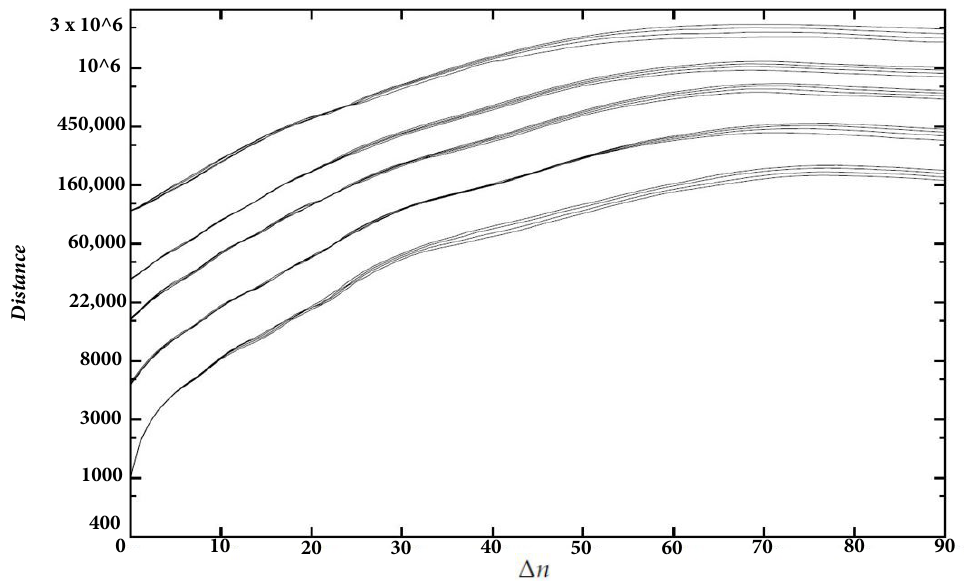
Figure 10. e S ( ∆ n ) for coop1 ( ε = 2500, 5000, 7000, 9000,